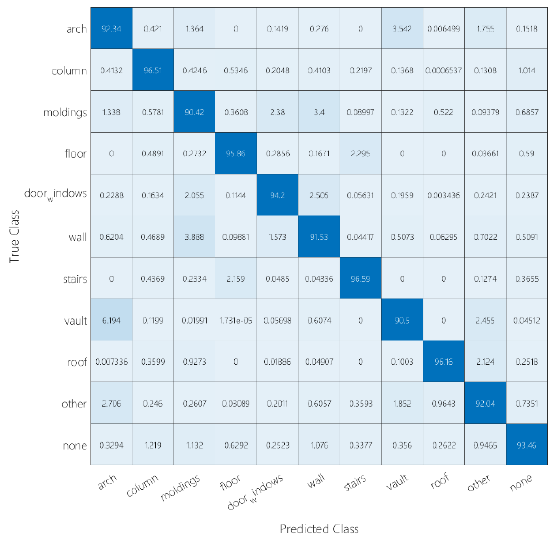
Figure 2: Confusion Matrix for Test 1 - Spedale del Ceppo This test was repeated for all the other buildings of the dataset, obtaining the results reported in Table 3.